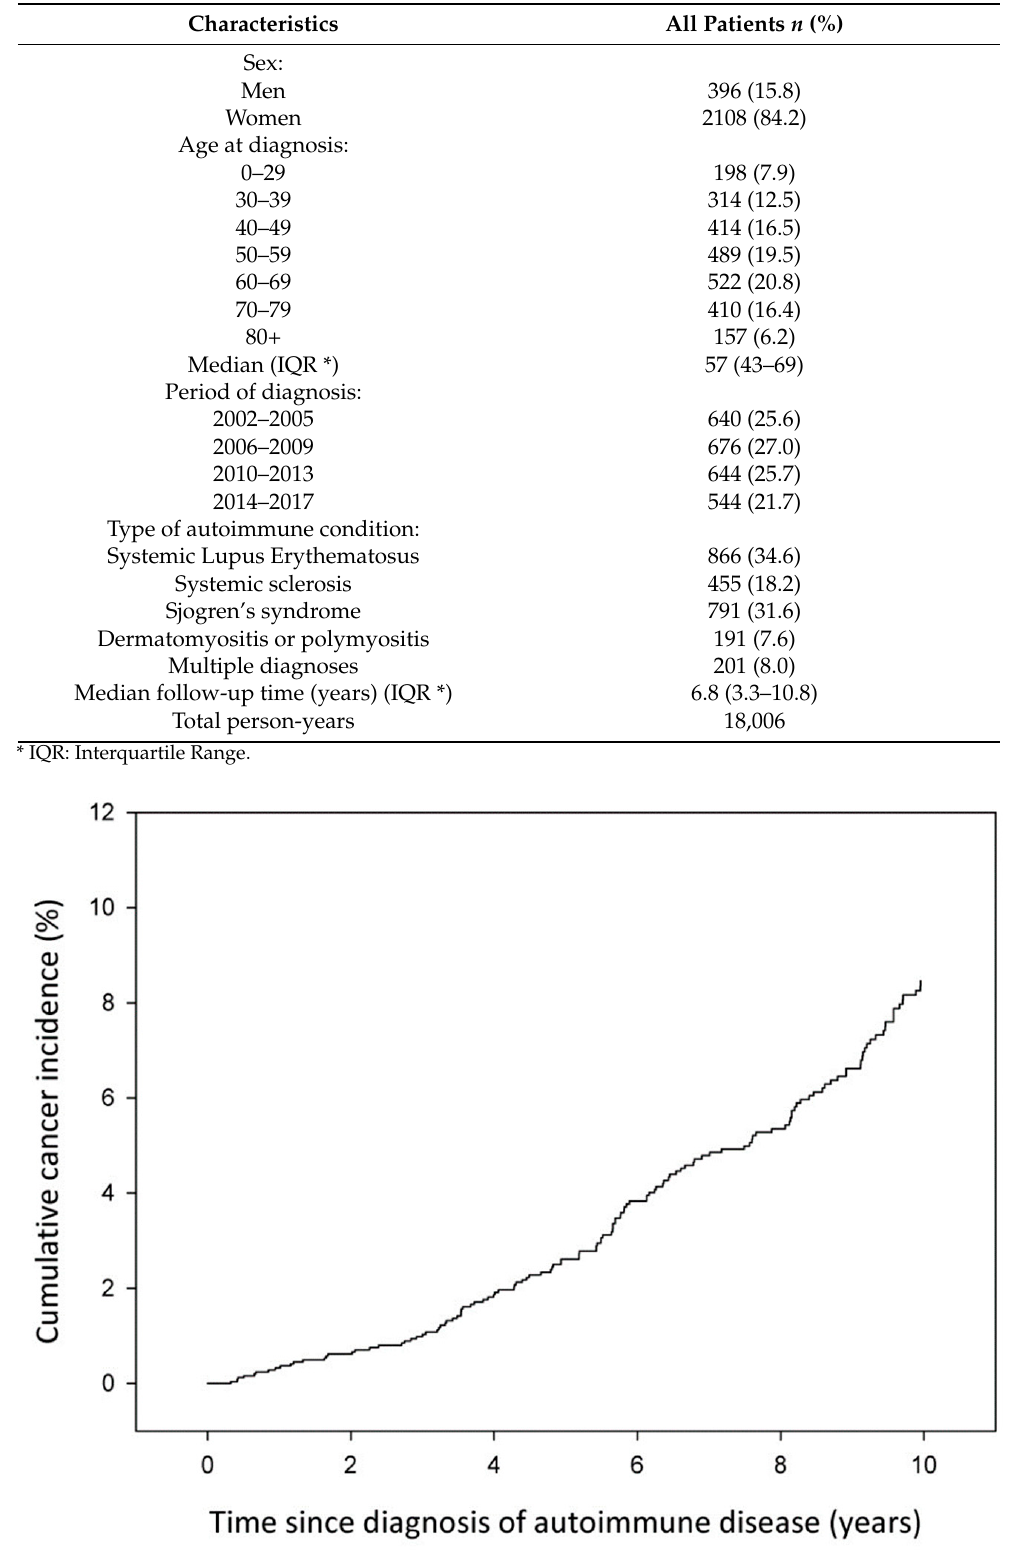
Table 1. Distribution of 2504 patients by selected characteristics. Friuli Venezia Giulia, 2002–2017.